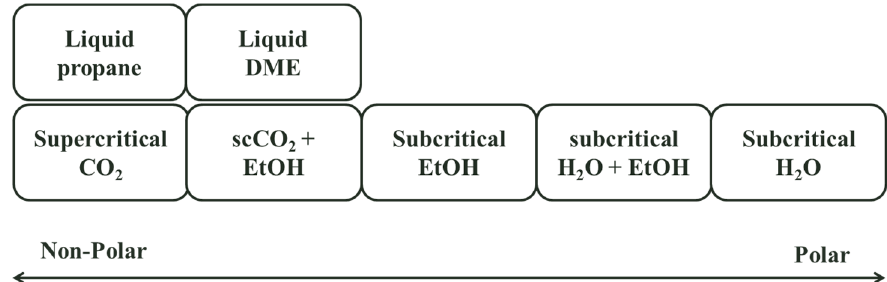
Figure 3. Sub- and supercritical mobile phases polarity.